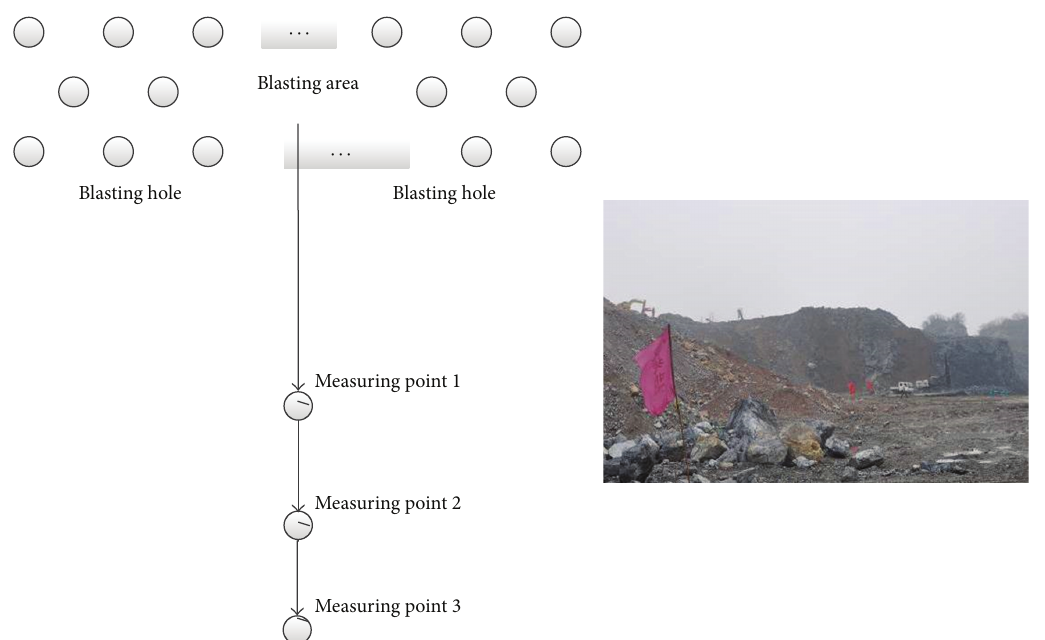
Figure 1: Schematic diagram and site layout of measuring points and blasting